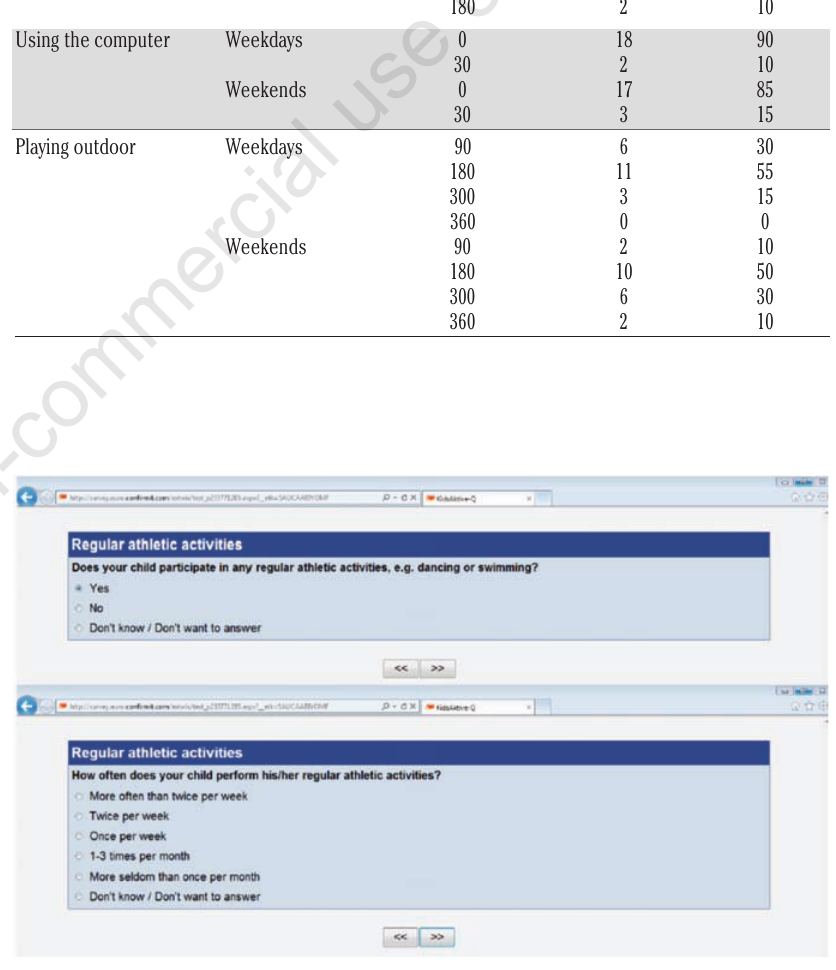
Figure 1. Screenshots of KidActive-Q showing a question regarding the performance of regular athletic activities, and a follow-up question if the response to the initial question is